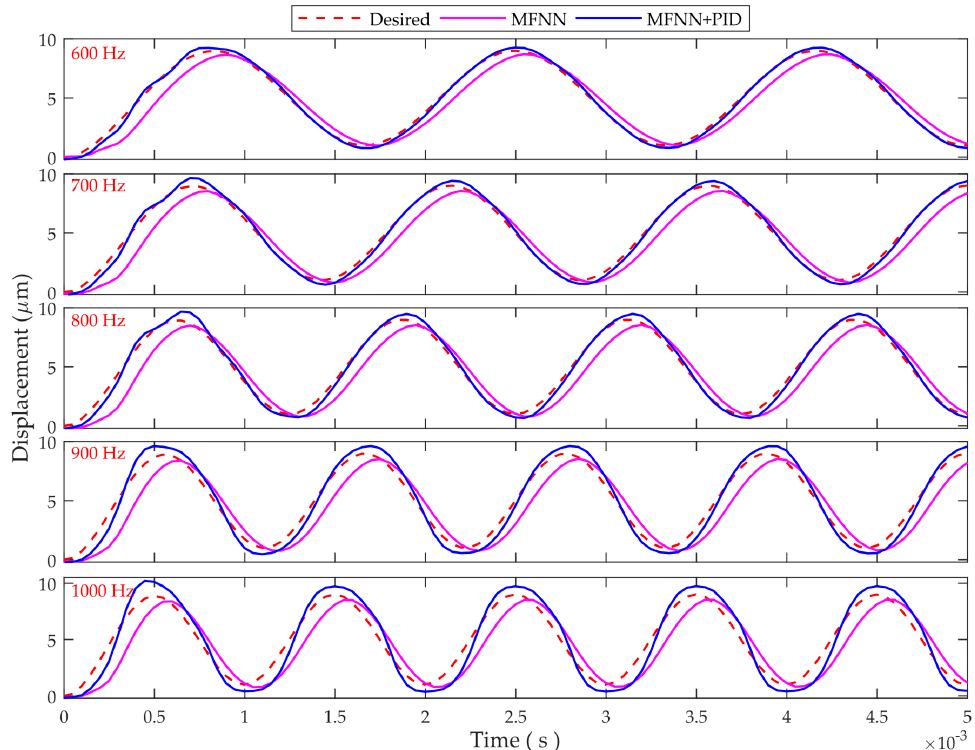
Figure 10. The tracking results of 600–1000 Hz sinusoidal trajectories, showing wide frequency range.